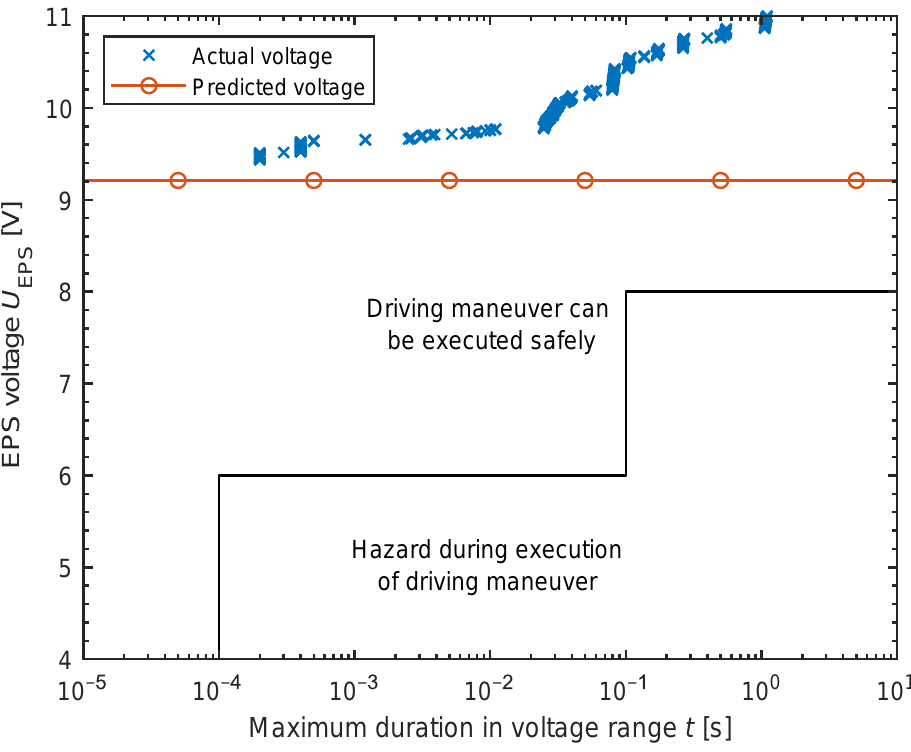
Figure 10. Comparison of minimum actual voltage U min,act,EPS = 9.42V versus minimum pre- dicted voltage U min,pred,EPS = 9.21V at the EPS during execution of critical driving maneuver with evaluation of maximum duration in permissible voltage range as described by Kilian